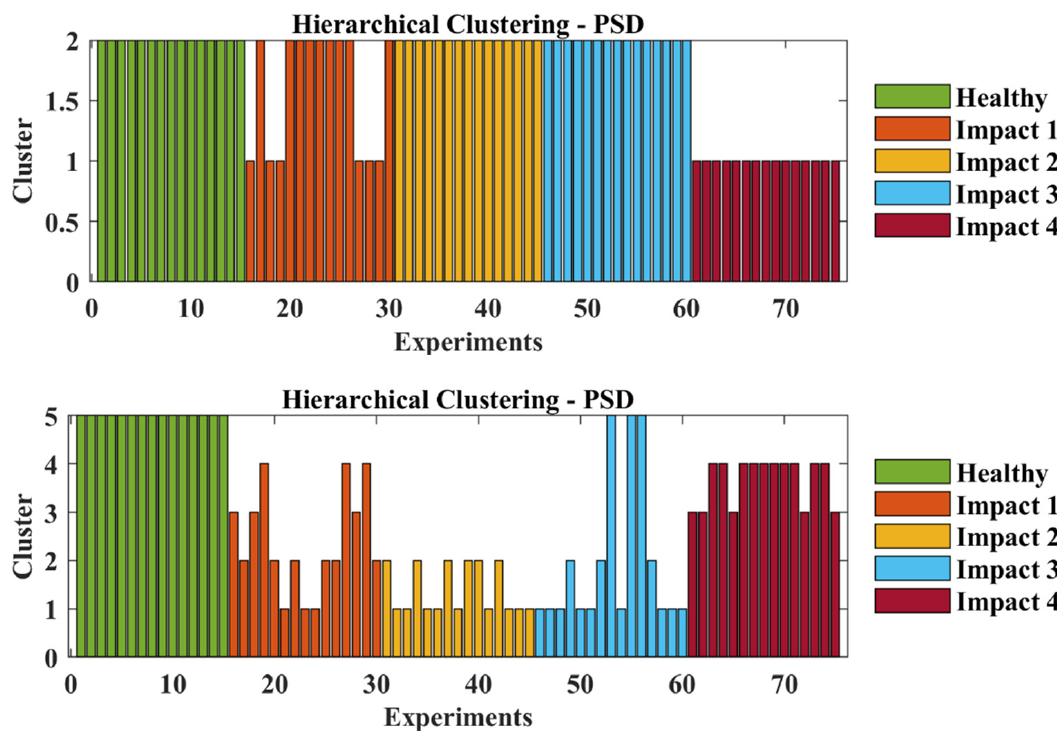
Figure 9. Hierarchical clustering using PSD. Input cluster = 2 ( up ), input cluster = 5 ( down ).